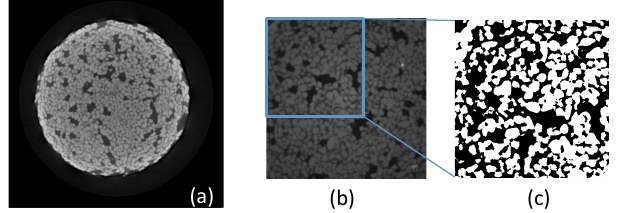
Fig. 2. View of a slice (1650 × 1650 pixels) of the CT image of the sand (a) . View of a slice (400 × 400 pixels) extracted of the 3-D Figure 2: View of a slice (1650x1650 pixels) of the CT image of the sand (a). View of a slice image (b) and segmented image (c) . In (a) and (b) the grey level (400 x 400 pixels) extracted of the 3D image (b) and segmented image (c). In figures (a) and intensity is proportional to the density of the material, while in the (b) the grey level intensity is proportional to the density of the material, while in the segmented image (c) the pore space is in black and the solid phase segmented image (c) the pore space is in black and the solid phase is in white. The porosity is in white. The porosity comprising pores ≥ 5µm diameter is 31%. comprising pores ≥ 5 µ m diameter is 31%.